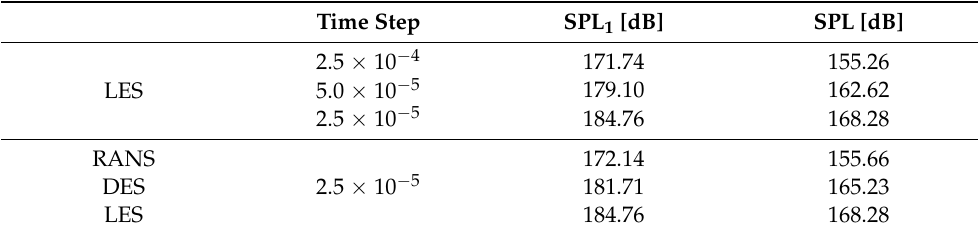
Table 10. Comparison difference of SPL 1 and SPL according to cavitating flow and wetted flow.